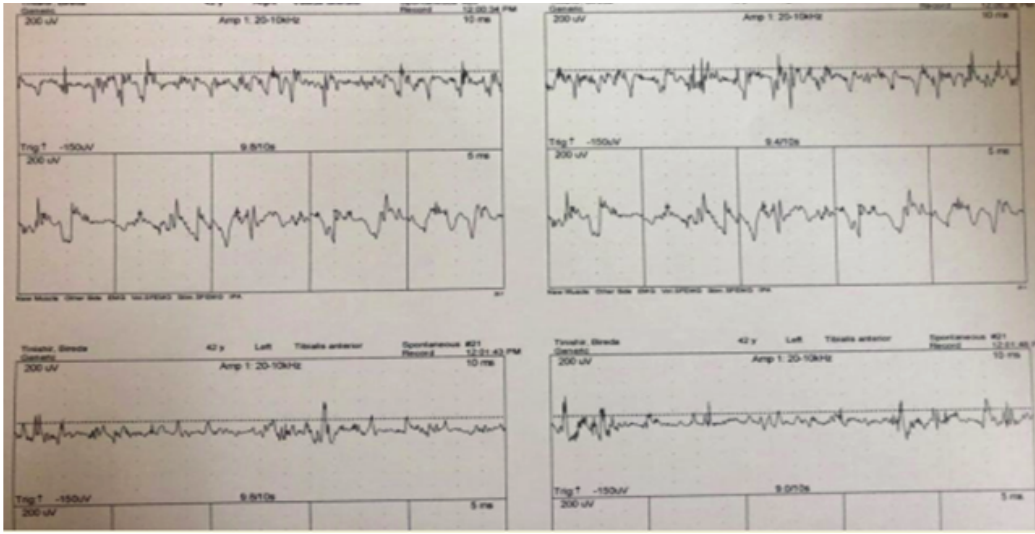
Figure 2: Electromyography (EMG) image showing small amplitude and duration Muscle Action Unit Potential (MUAP) suggesting myopathic patterns.